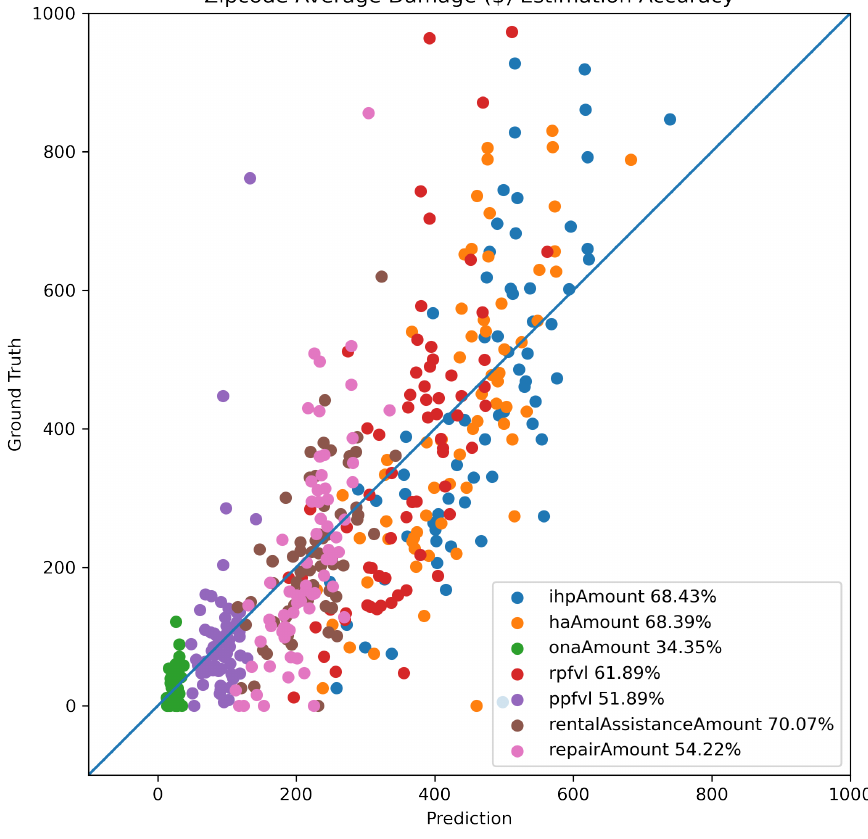
Figure 3. Zip code average damage ($) estimation